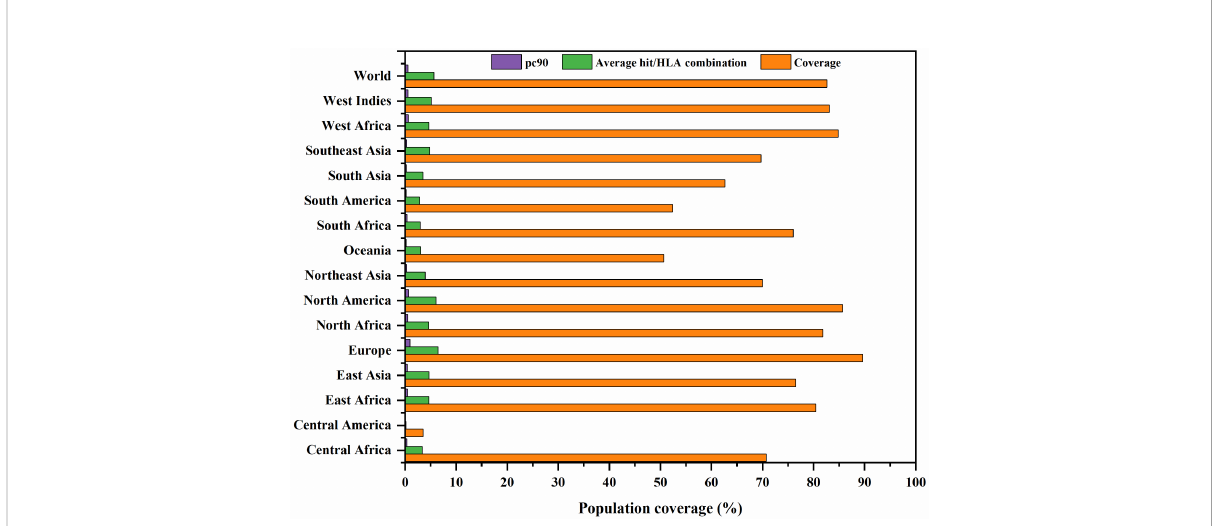
FIGURE 2 Global population coverage of selected MHC class I epitopes. pc90, the minimum number of epitope hits/HLA combinations recognized by 90% of the population; Coverage, projected population coverage; Average hit/HLA combination, an average number of epitope hits/HLA combinations recognized by the population.